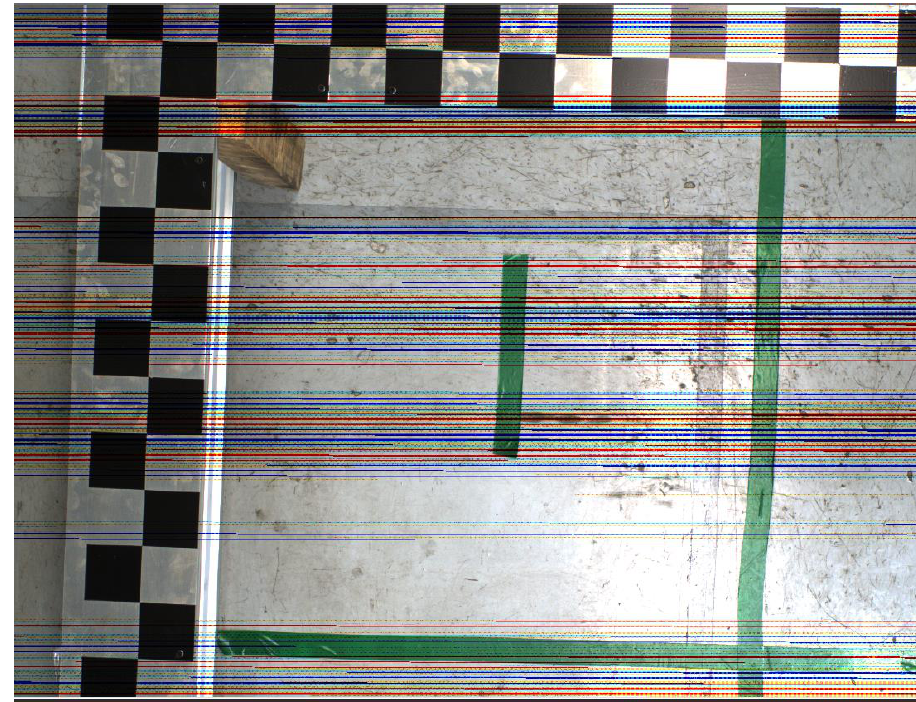
Processes 2021 , 9 , x FOR PEER REVIEW Figure 9. Image noise. Figure 9. Image noise.